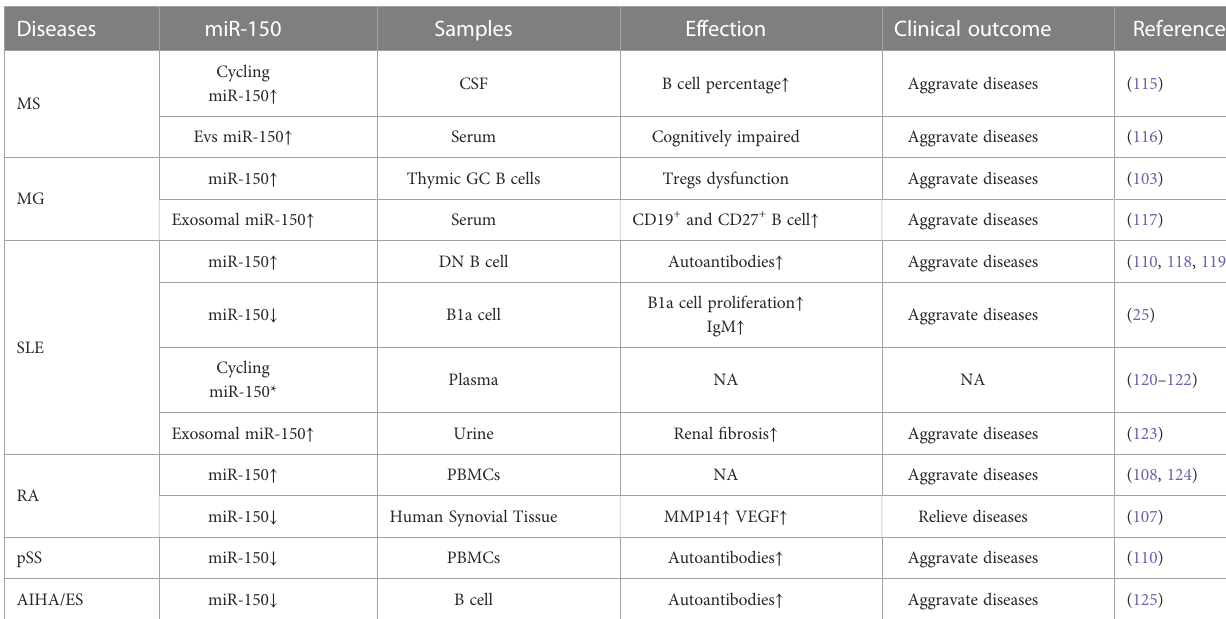
TABLE 2 Regulation of miR-150 in autoimmune